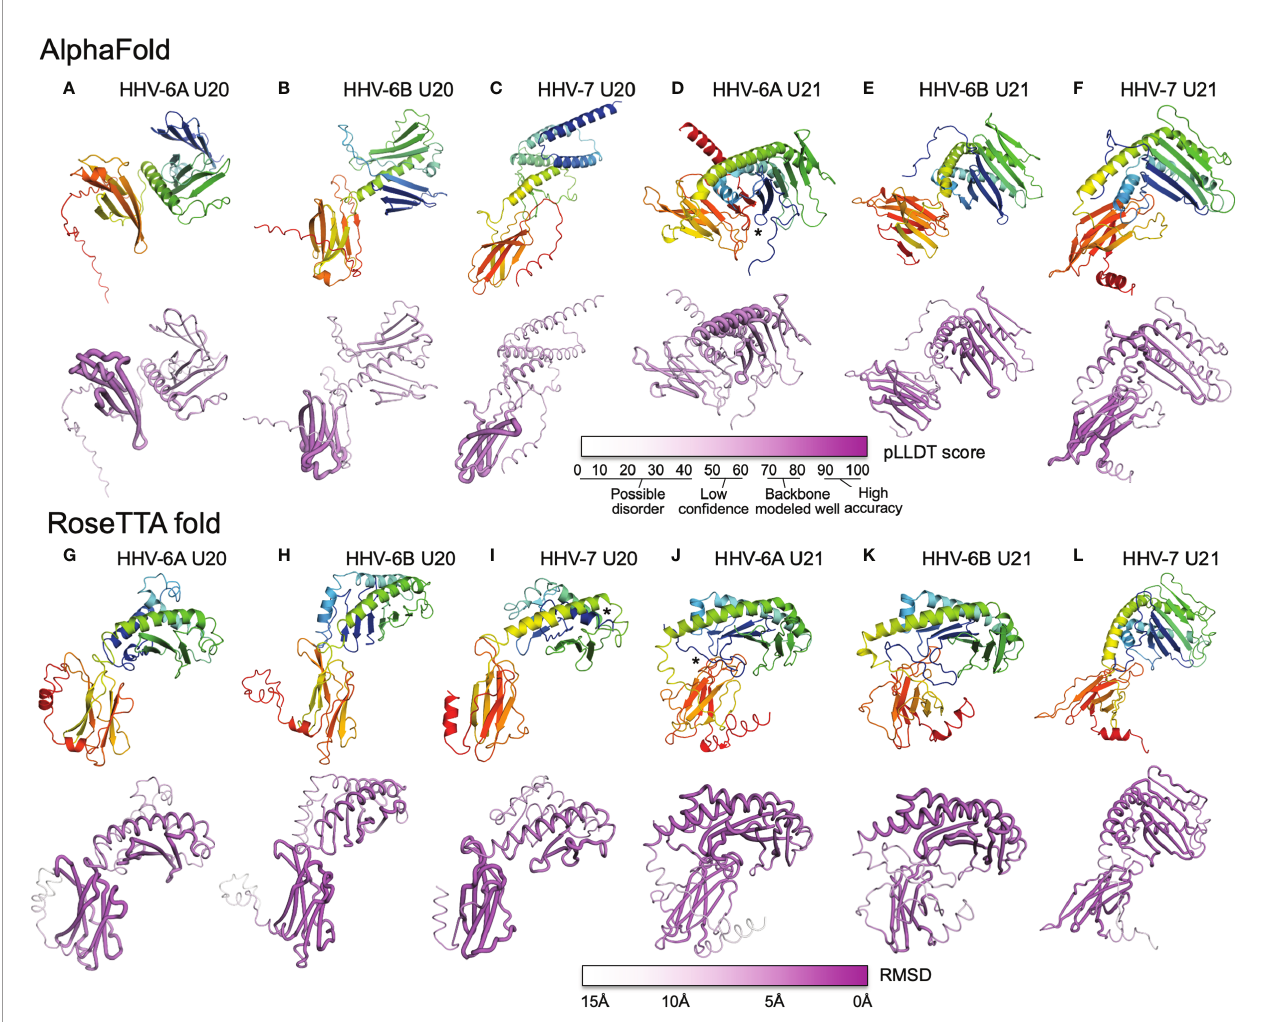
FIGURE 7 | AlphaFold and RoseTTAfold structures for U20 and U21. AlphaFold structure predictions for U20 from HHV-6A (A) , HHV-6B (B) , and HHV-7 (C) , and for U21 from HHV-6A (D) , HHV-6B (E) , and HHV-7 (F) . RoseTTAfold structure predictions for U20 from HHV-6A (G) , HHV-6B (H) , and HHV-7 (I) , and for U21 from HHV-6A (J) , HHV-6B (K) , and HHV-7 (L) . The same sequences used in the alignments were processed through SignalP to identify signal sequences and TMHMM to identify transmembrane domains (73, 74). The sequences were then truncated to re fl ect the extracellular portion of the protein before use for structure prediction. For Phyre2, sequences were submitted for analysis via the Phyre2 server utilizing the “ Intensive ” modeling mode (57). For I-TASSER, we provided a protein sequence and speci fi ed no constraints or template exclusions (59). For AlphaFold we used the AlphaFold2 Advanced Script hosted by Google Colab (23). We used the default settings, speci fi cally utilizing de novo generation of multisequence alignments with mmseqs2. We generated 5 models for each prediction with 1 ensemble, 3 recycles, a tolerance of 0, and 1 random seed. For RoseTTAfold we used the Robetta server and predicted on a single sequence using the “ RoseTTAFold ” method with no additional constraints (24). Both AlphaFold2 and RoseTTAFold generate several structural models from each modeling run. Figures were generated using the top-scoring model. For AlphaFold and RoseTTAfold, the top fi ve scoring models from each run were examine for consistency with the model presented. Scale bars representing the con fi dence intervals are shown on a linear scale, RMSD for Phye2 and RoseTTA, TM-score for ITASSER, and pLDDT for AlphaFold. (A-L) Predicted structural models and previously determined crystal structures were visualized and fi gures were prepared using the Pymol molecular graphics program (75). Ribbon and tube diagrams colored as in Figure 5 . Asterisks indicate features highlighted in